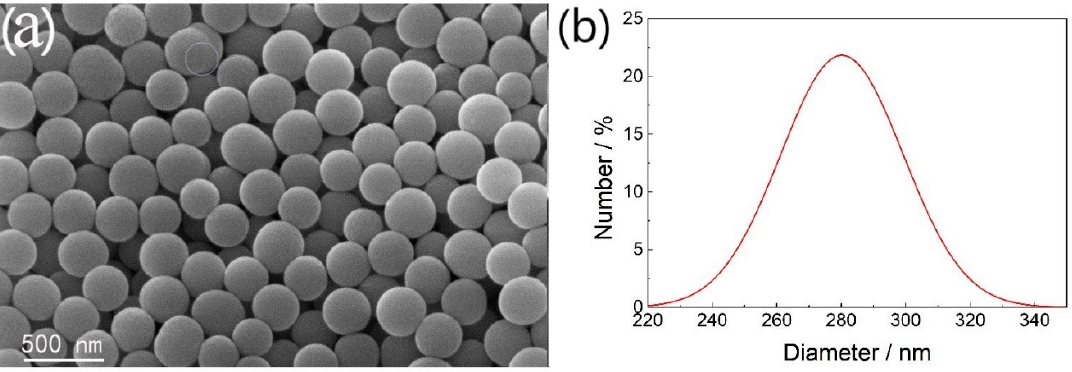
Figure 11. ( a ) SEM images and ( b ) size distribution curve of SiO 2 particles.